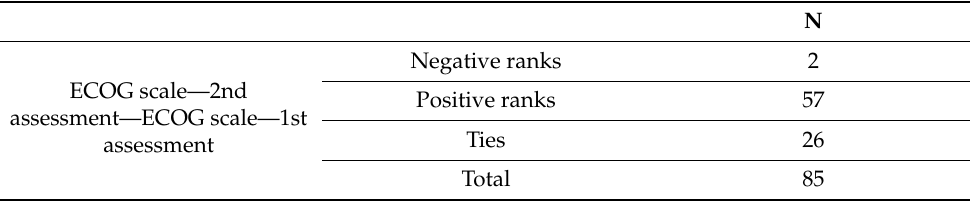
Table 3. Ranks of performance status (ECOG).